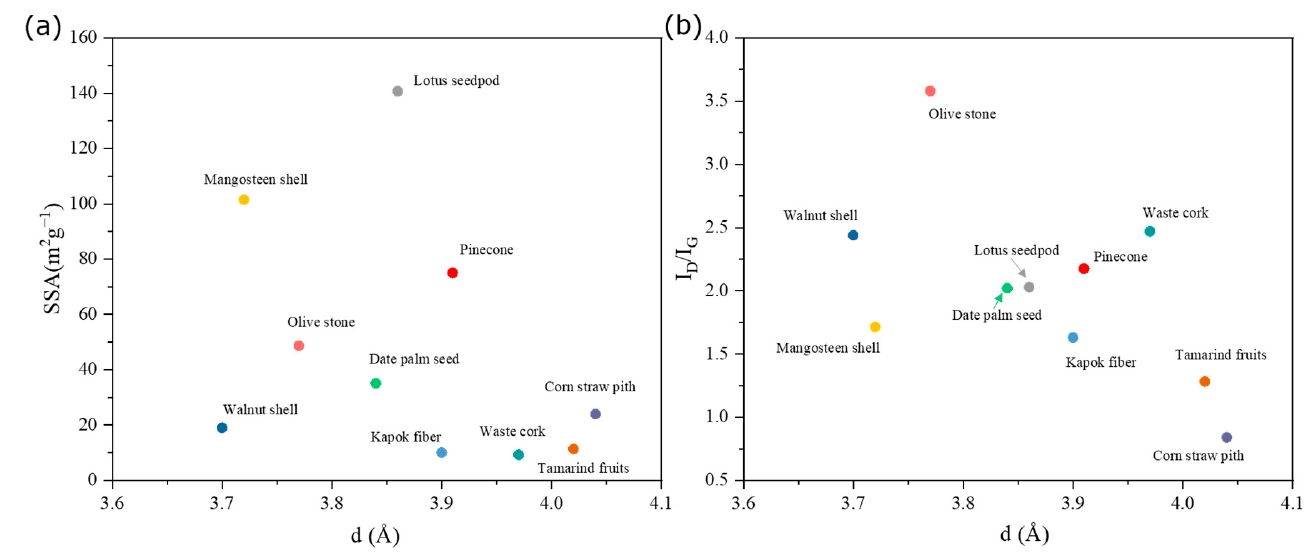
Figure 4. Hard carbon structure properties for different biomasses tested using the same condition (1200 °C for 2 h), including the relationship between d-spacing and ( a ) SSA, and ( b ) I D /I G . (Pinecone [56]; Mangosteen shell [57]; Lotus seedpod [58]; Waste cork [59]; Olive stone [78]; Walnut shell [79]; Kapok fiber [80]; Date palm seed [81]; Corn straw pith [82]; Tamarid fruits [83]).